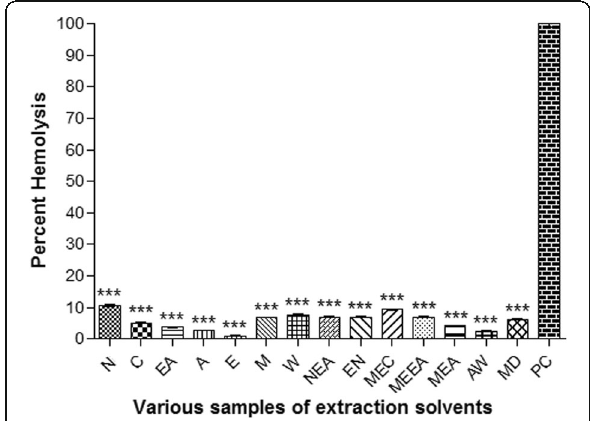
Fig. 6 Percent hemolytic potential of various samples of